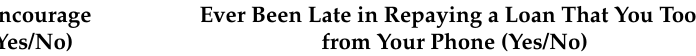
Table 3. Association between betting and digital credit